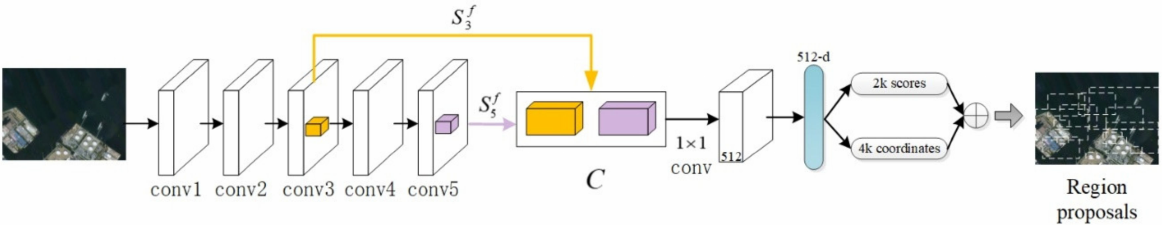
Figure 3. The general framework of the multi-scale local context region proposal network